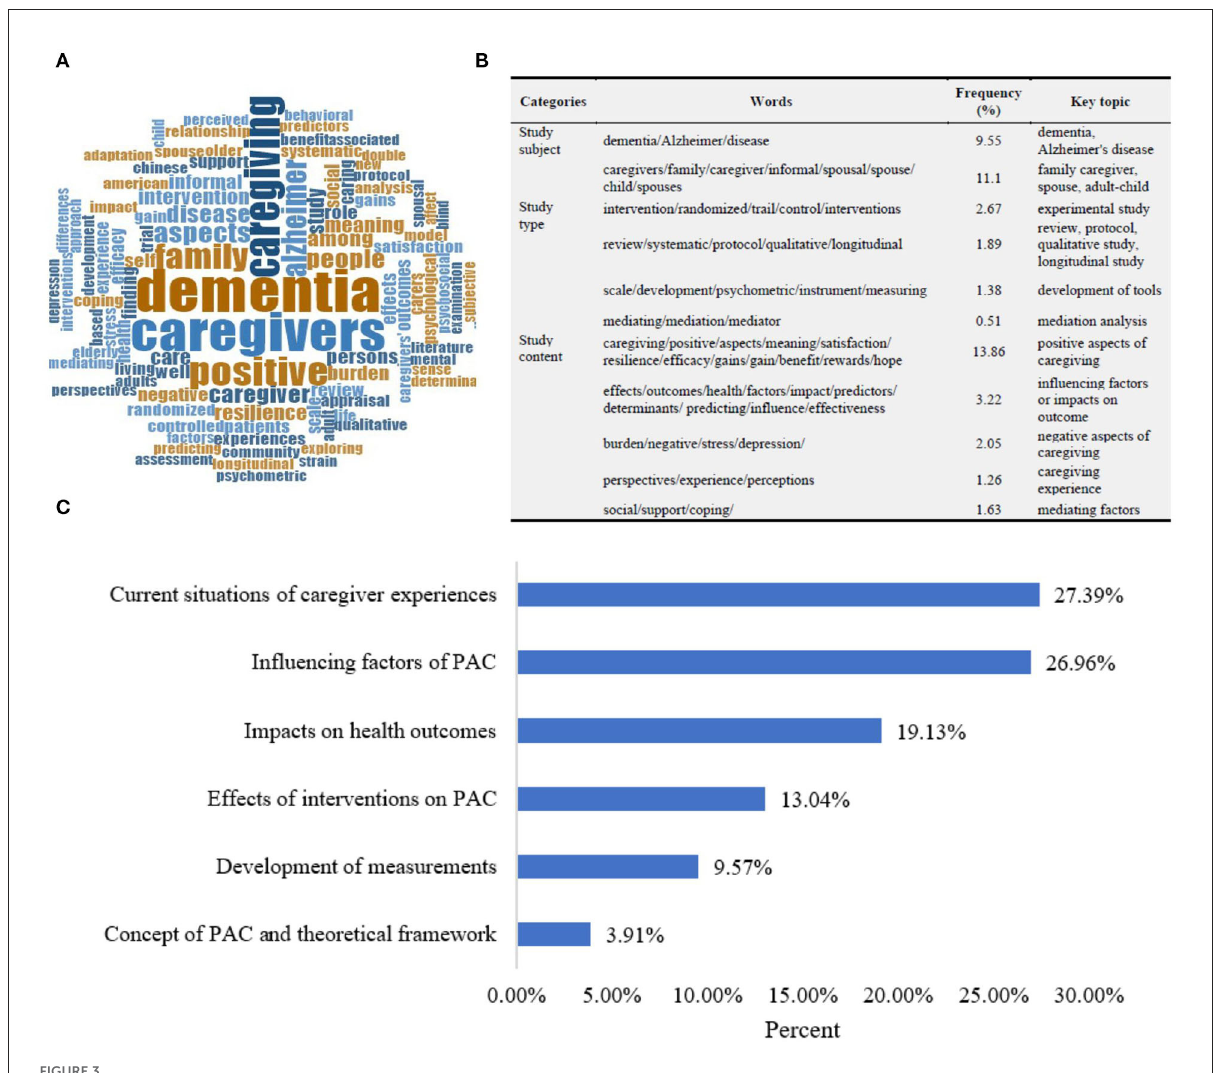
FIGURE3 Word cloud analysis of titles (A,B) and research key topics of included literature (C) .